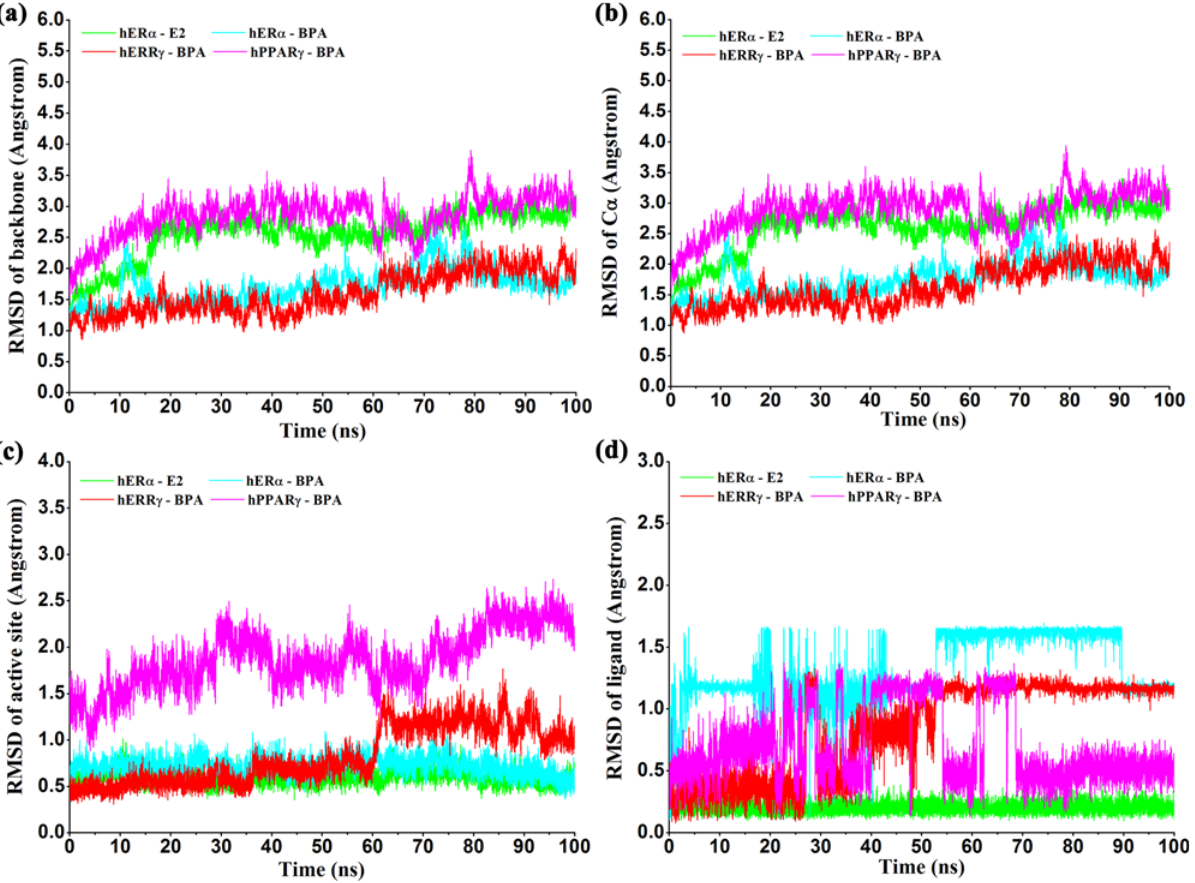
Fig 2. Monitoring of the equilibration of the MD trajectories of the four complexes. a) Time evolution of the RMSD of all protein backbone atoms (C, CA, N); b) Time evolution of the RMSD of C α atoms of the protein; c) Time evolution of the RMSD of the C α atoms of residues around 5 Å of the ligand; d) Time evolution of the RMSD of heavy atoms for the